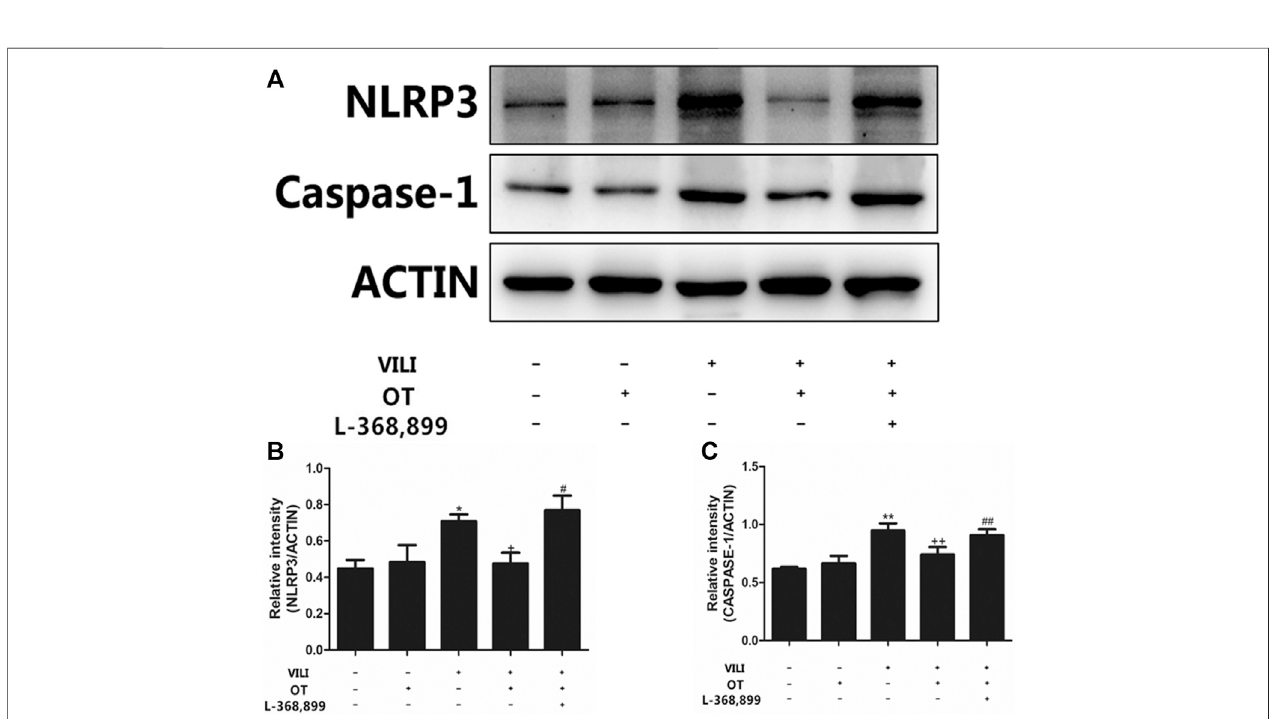
FIGURE 7 | Effects of oxytocin on the expression of NLRP3 and Caspase-1.OT administration inhibited NLRP3 and Caspase-1 expression in the mouse VILI model. Western blot was performed to evaluate the protein expression of NLRP3 and Caspase-1 in lung tissue exposed to mechanical ventilation (A) . The levels of NLRP3 (B) and Caspase-1 (C) protein expression were quanti fi ed by measuring band intensities and displayed as fold increase relative to ACTIN. The values presented are the means ± SD ( n (cid:2) 5). * p < 0.05 and ** p < 0.01 comparedwiththe Control and Control +OT groups, # p < 0.05and ## p < 0.01 compared with theVILI group, and + p < 0.05 and +++ p < 0.01 compared with the OT + VILI group. OT, oxytocin; SD, standard deviation; VILI, ventilation-induced lung injury.